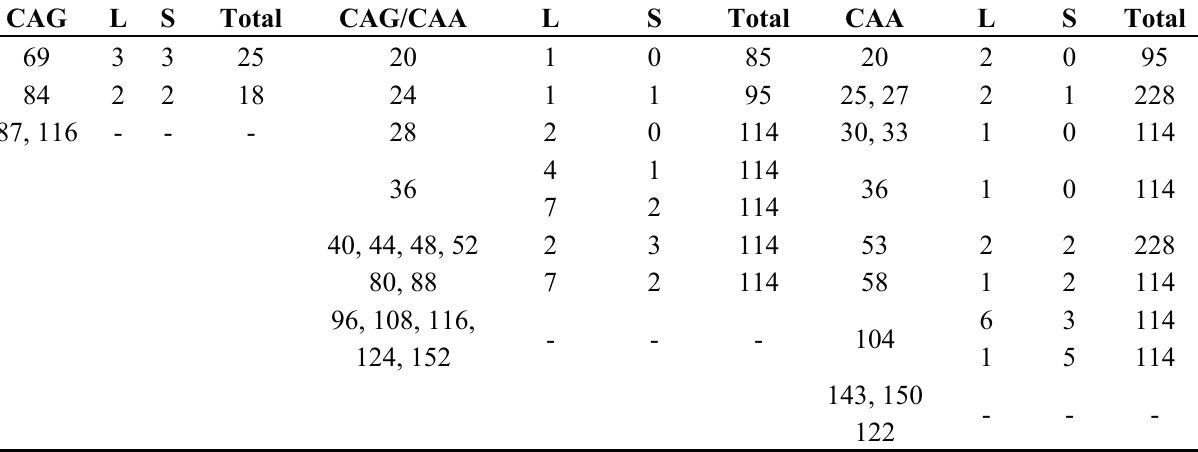
Table 1. Results of a series of SLIP experiments showing the efficiency of elongation of a particular repeat tract. L, the number of elongated clones; S, the number of shortened clones; total, the number of screened clones; “-” indicates that SLIP was not performed. When several variants of repeat length were obtained and confirmed by sequencing, the longest one was used in additional experiments. For 104 CAA and 36 CAG/CAA variants, two SLIP experiments were